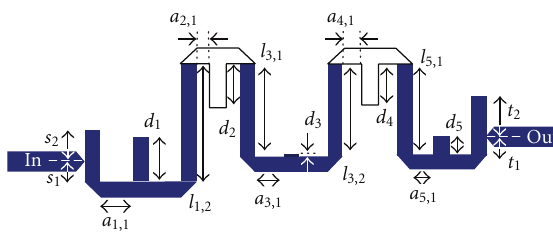
Figure 7: Schematic of the proposed multilayered microstrip hairpin filter.